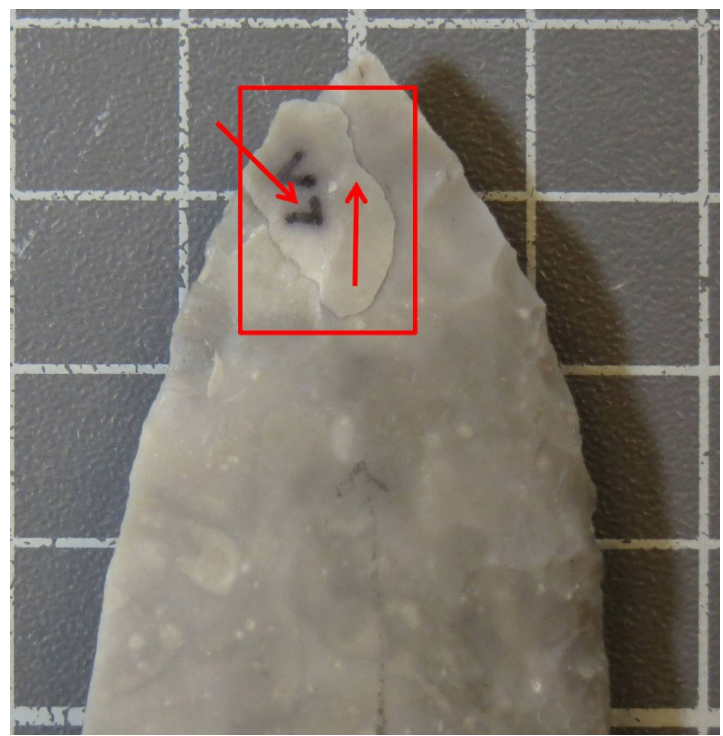
Figure 17. Blade-point 4.3, flake v7 with the red arrows indicating the dorsal scar pattern (photograph by the author). Gridlines on this image are 10mm